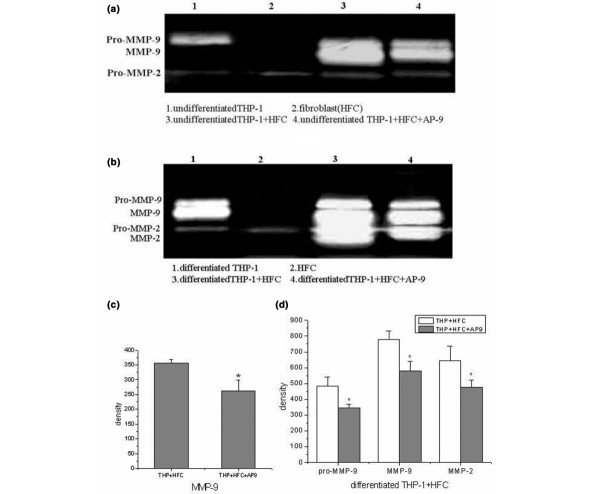
Matrix metalloproteinase (MMP) secretion in a co-culture of THP-1 cells and human fibroblast cells (HFC). (a) Gel zymography detection of MMP-2 and MMP-9 in undifferentiated THP-1 cells, in HFC, and in a co-culture of the two. Elevated release and activation of MMP-2 and especially MMP-9 was seen in the co-culture cells compared to the cultures of THP-1 cells or HFC alone. (b) Gel zymography detection of MMP-2 and MMP-9 in phorbol myristate acetate (PMA)-induced differentiated THP-1 cells, in HFC, and in a co-culture of the two. Pro-MMP-2 and MMP-2 release was higher in the co-cultured cells. PMA-induced differentiated THP-1 cells secreted more pro-MMP-9 and MMP-9 compared with undifferentiated THP-1 cells. (c) Effects of CD147 antagonistic peptide 9 (AP9) on MMP-9 release in a co-culture of undifferentiated THP-1 cells and HFC. The zymography gels above were scanned and the gray density of strips was counted. The release and activation of MMP-9 was significantly reduced when AP9 was added. The asterisk indicates a p-value < 0.01. (d) Effects of AP9 on the release of pro-MMP-9, MMP-9 and MMP-2 in a co-culture of differentiated THP-1 cells and HFC. Pro-MMP-9, MMP-9 and MMP-2 secretion all decreased significantly in the AP9 group. Asterisks indicate a p-value < 0.01. HFC, Human fibroblast cells.